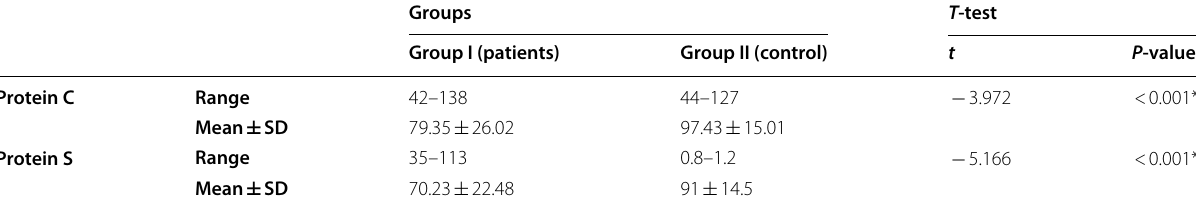
Table 2 Protein C and S activity difference between the study groups